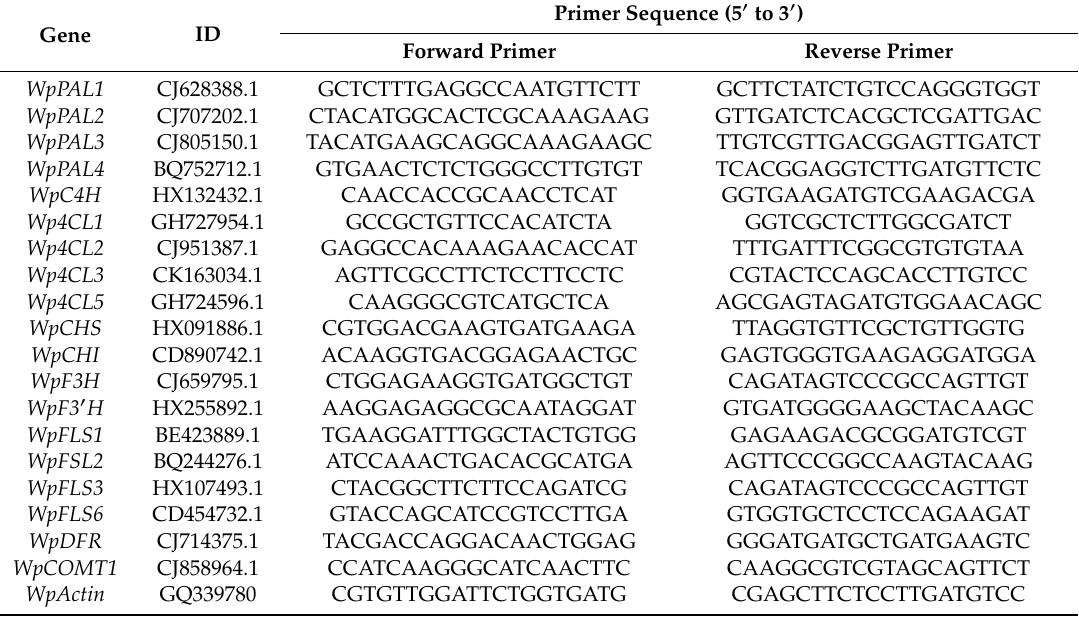
Table 1. Primers used in this study for quantitative real-time PCR